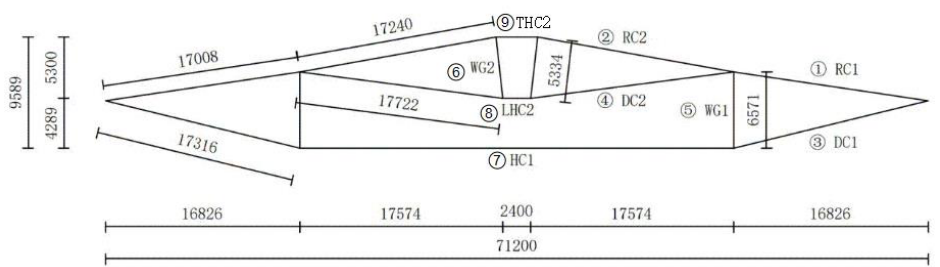
Figure 1. Structural profile and size of the considered structure (mm). Table 1. Areas of the element sections and initial prestress values. Element